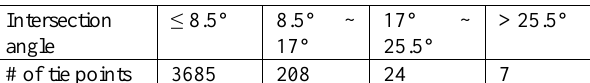
Table 6. Number of tie points in different intersection angles